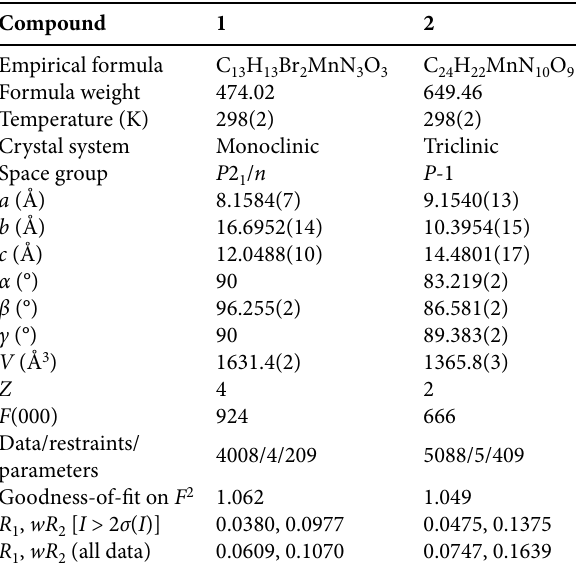
Table 1. Crystallographic data for the single crystal of the complexes.